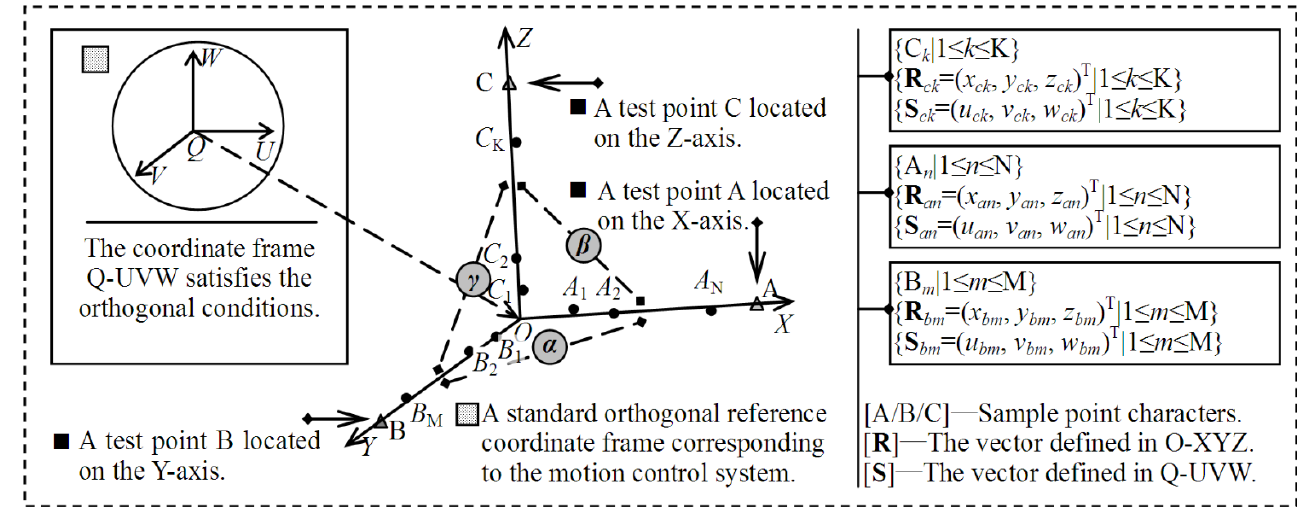
Figure 3. The method to estimate the intersection angles between the coordinate axes of the motion trajectory coordinate frame.